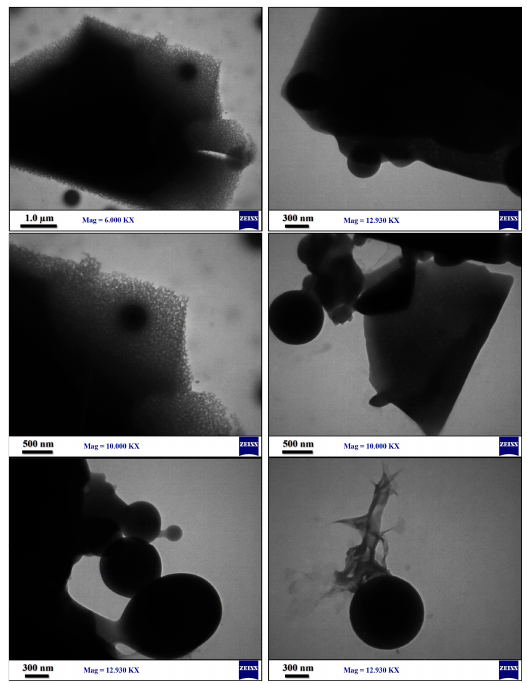
Figure 8. TEM micrographs of NC